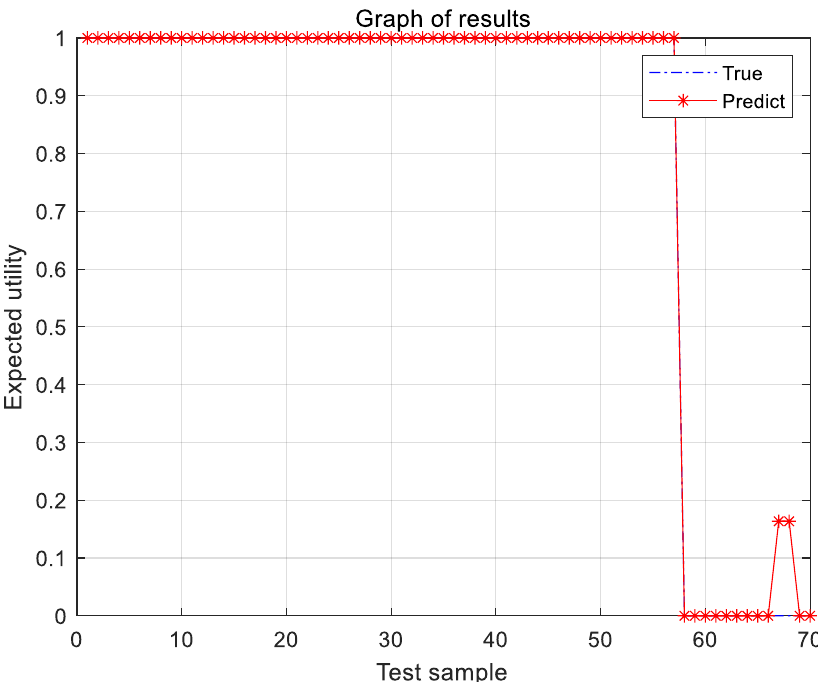
Figure 5. Plot of the intervals-BRB model fits after process.